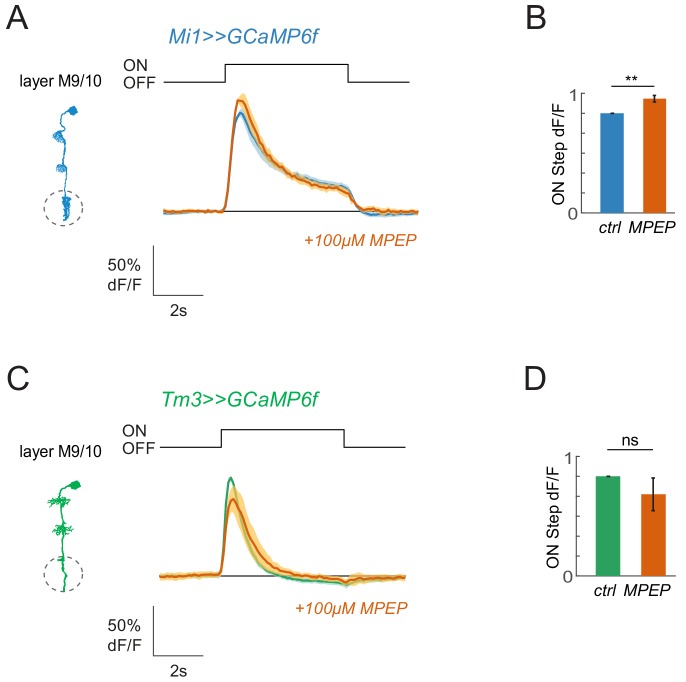
Blocking metabotropic glutamate receptors does not abolish ON responses.(A,C) GCaMP6f signals in response to 5 s full-field flashes in layer M9/10 before (blue for Mi1, green for Tm3) and after (orange) application of 100 µM MPEP. The same cells were imaged before and after drug application. Sample sizes were n = 5 (58)±MPEP for Mi1, and n = 5 (40)±MPEP for Tm3. (B,D) Bar plots showing the quantification of the ON step. *p<0.05, **p<0.01, ***p<0.001, tested with paired Student t test. All traces and bar plots show mean ± SEM. Sample sizes are given as n = number of flies (number of cells).10.7554/eLife.49373.006Figure 2—figure supplement 1—source data 1.Table 1 contains all mean ± s.e.m.Data related to quantifications shown in main Figure 2—figure supplement 1, sorted by genotype and experimental condition.